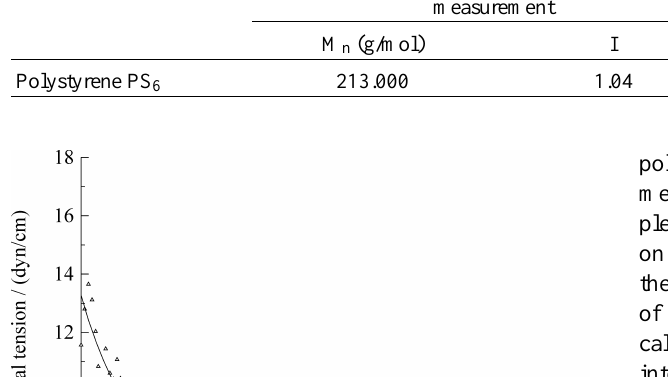
Table 2. Molecular weight of a the polystyrene before and after the experiment. Polymer Molecular weight before interfacial tension measurement